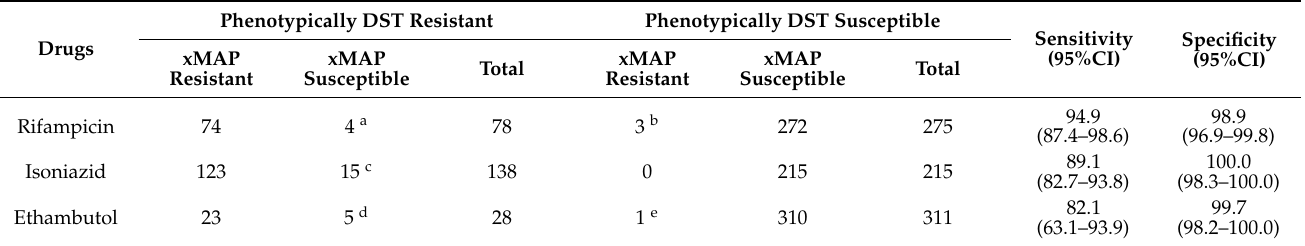
Table 2. Diagnostic performance of the xMAP TIER assay compared with the phenotypic DST method for detection of RIF, INH, and EMB